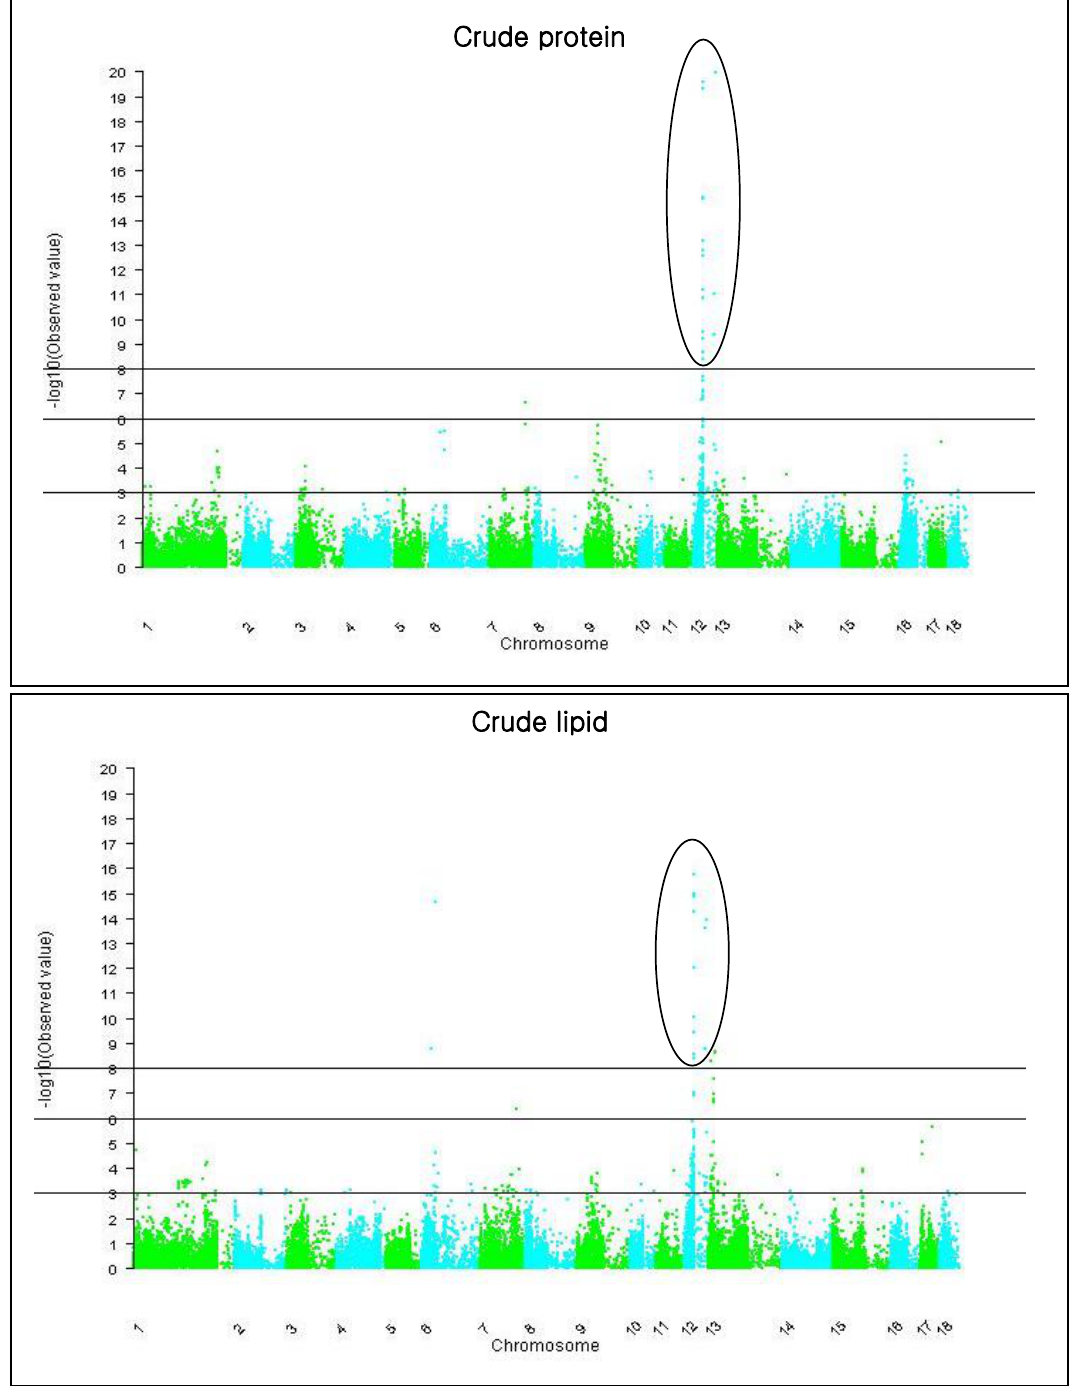
Figure 1. Test statistic profiles for crude protein, crude lipid, crude ash and Cie a under the additive and dominance model for each SNP. Circles indicate highly significant QTL. Y axis indicates -log 10 (p -value under the null hypothesis of no SNP